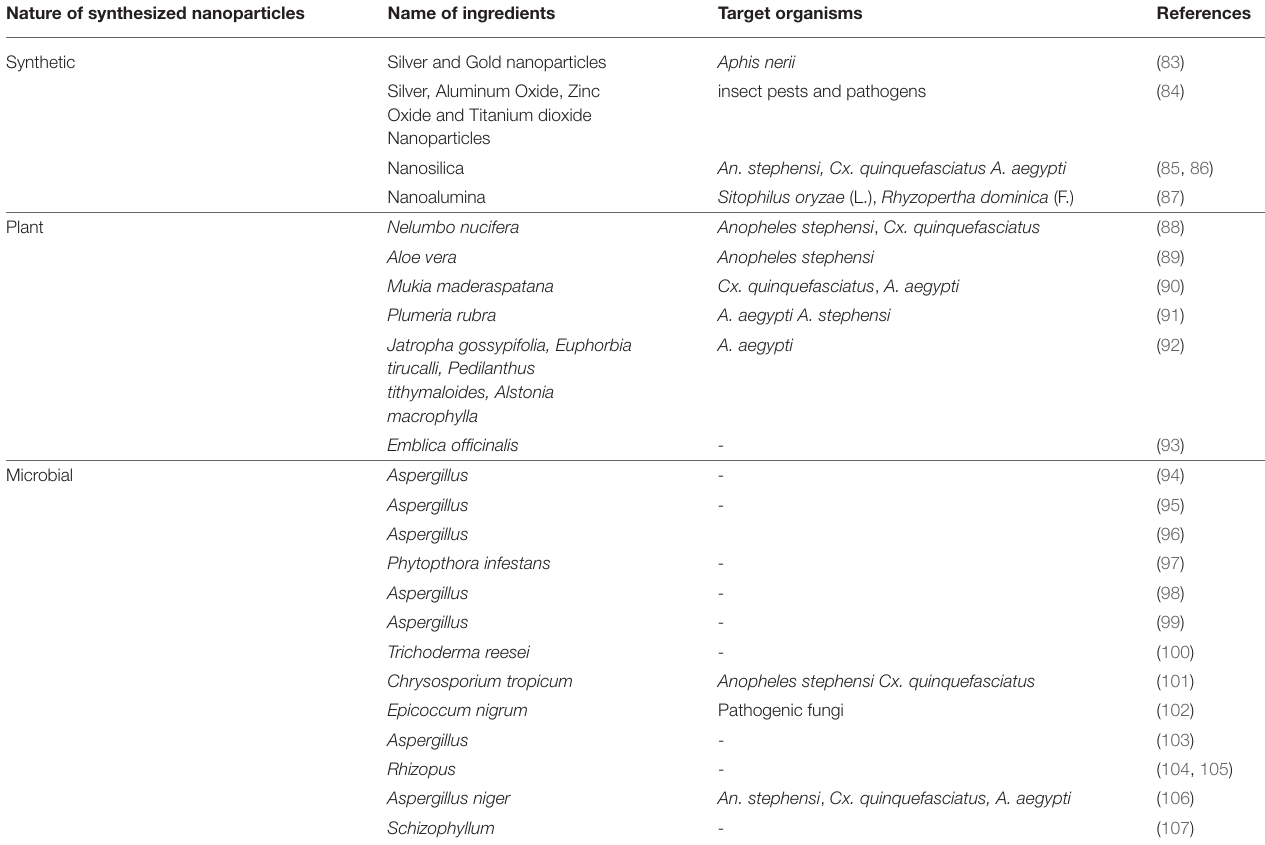
TABLE 4 | List of various non-encapsulated nanopesticides used against insect pest management. Nature of synthesized